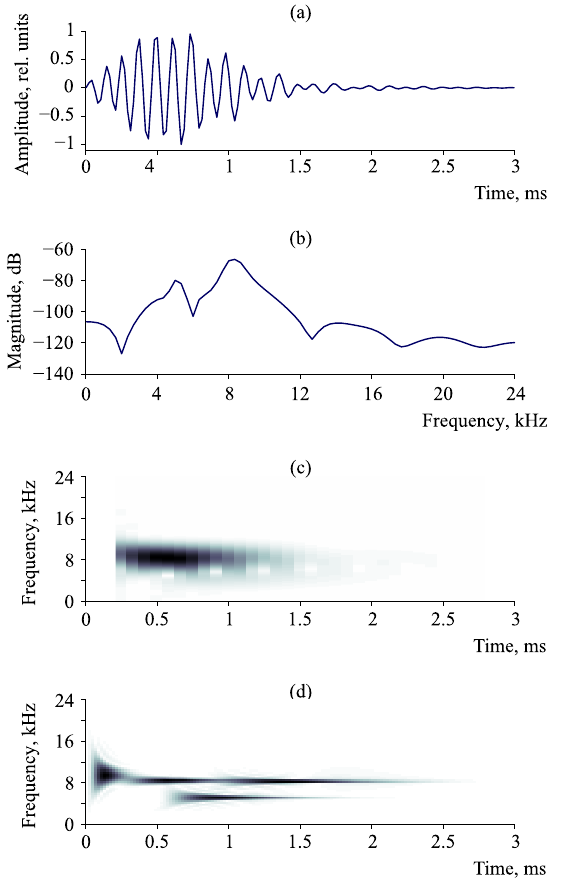
Figure 10. Comparison of different methods of frequency and time-frequency analysis: ( a ) signal, ( b ) estimate of spectral power density by Fast Fourier transform, ( c ) Short Time Fourier transform and ( d ) sparse approximation (Adaptive Matching